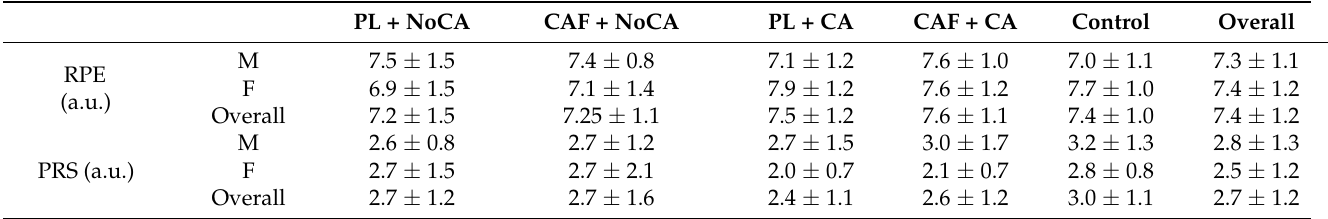
Table 3. Rating of perceived exertion and perceived recovery status scores across different conditions (values are mean ± SD; n =